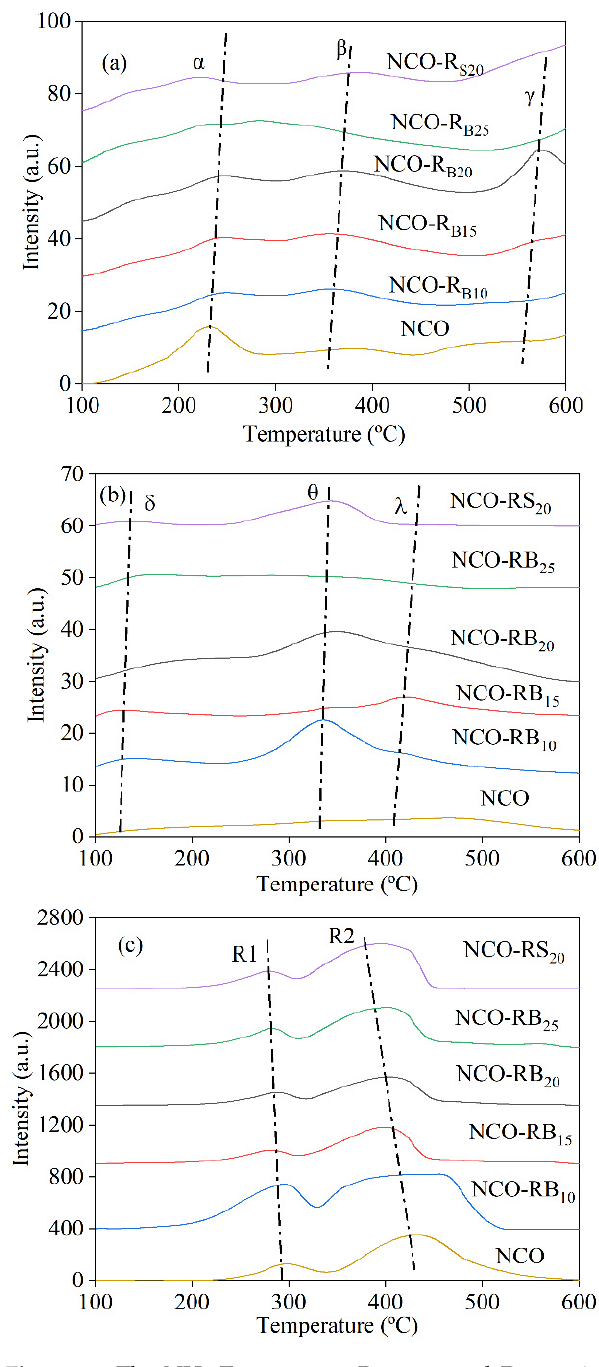
Figure 3. The NH 3 -Temperature Programmed Desorption (TPD) profiles ( a ), O 2 -TPD profiles ( b ) and H 2 - Temperature Programmed Reduction (TPR) profiles ( c ) of NCO, NCO-RB 10 , NCO-RB 15 , NCO-RB 20 , NCO-RB 25 , and NCO-RS 20.